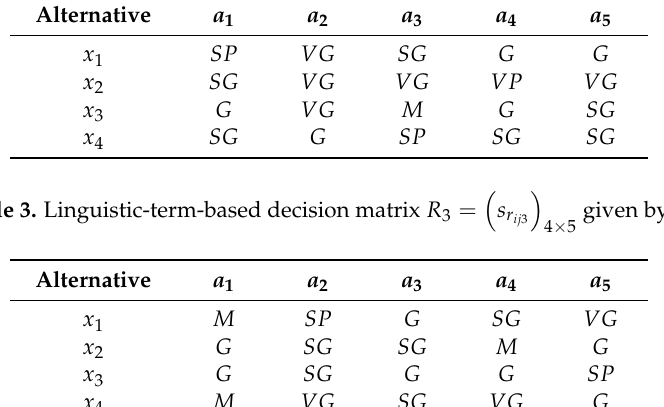
(cid:16) (cid:17) s r given by e 2 . ij 2 4 × 5